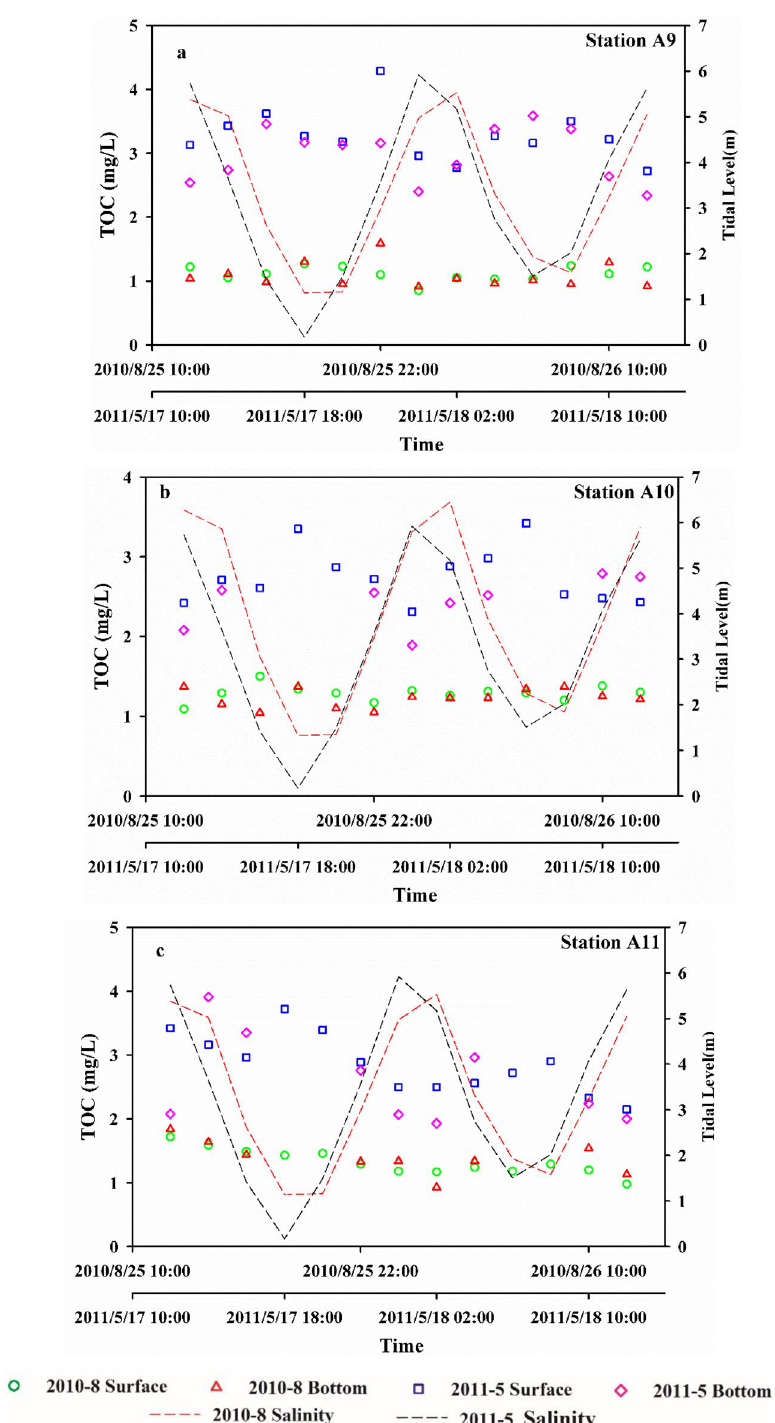
Figure 6. Diurnal variations of TOC concentrations in summer and spring. ( a ) Station A9. ( b ) Station A10. ( c ) Station A11. These figures were prepared using Sigma-Plot Version 10.0 (Systat Software, Inc., San Jose, California,